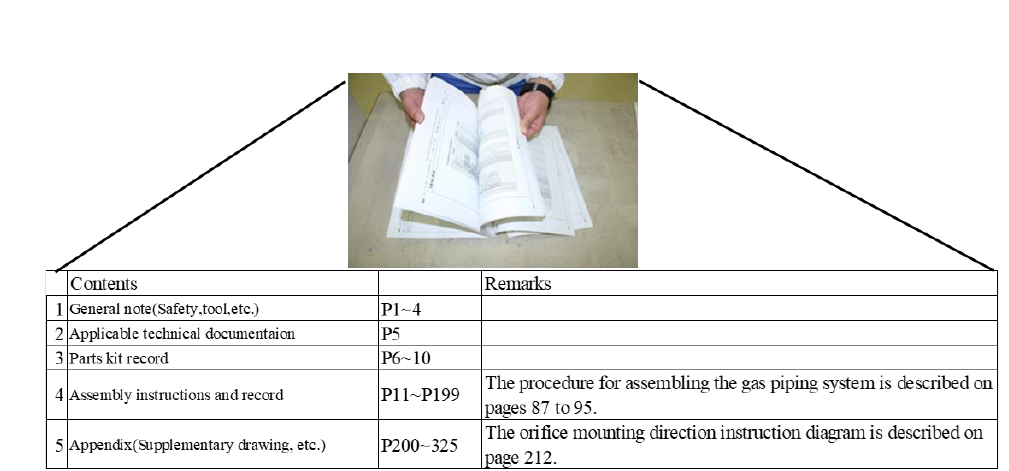
Figure 5. Work procedure